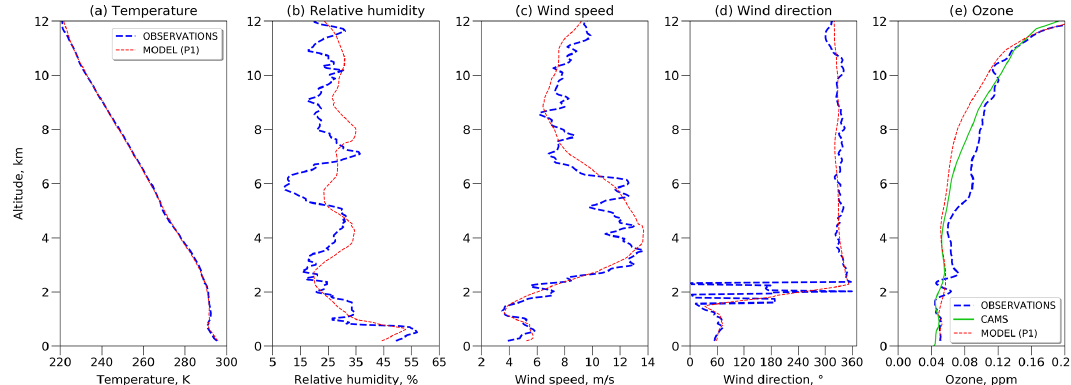
Figure 8. Vertical profile of meteorological parameters and ozone mixing ratio measured by ozonesonde on 28 June 2019 (dashed blue line) and calculated by WRF-Chem (red dotted line), shown between 0 and 12km (approximate tropopause height) for one PBL scheme (P1). The ozone profile from the CAMS analysis (green) is also shown in panel (e) .